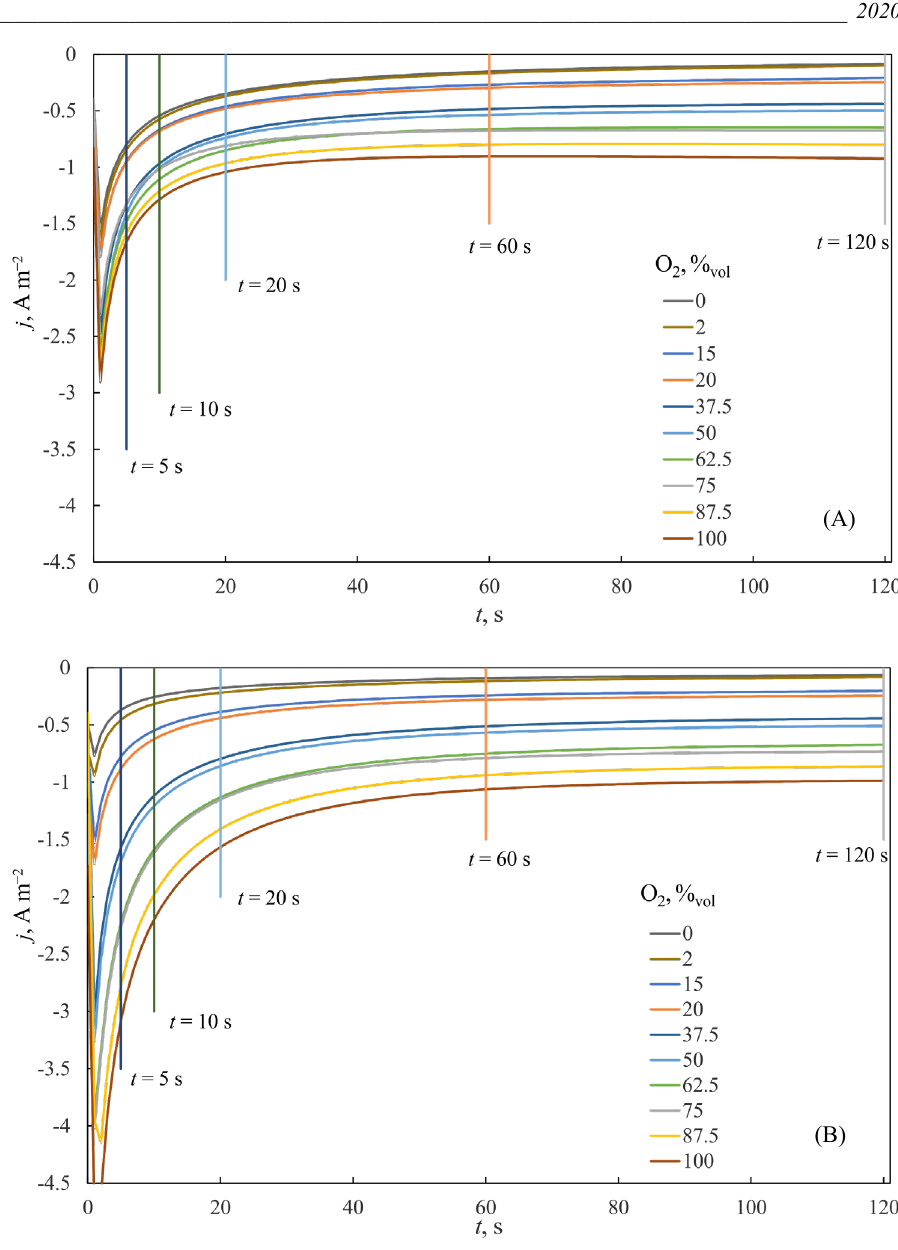
Fig. 5. The dependence of the current density, j , on the time, t , after the potential step of platinum electrode from 0.5 V to −0.5 V vs Ag|AgCl|0.1 M KCl for the 0.1 M KCl solution saturated with mixture of nitrogen and oxygen ( p tot = 101 kPa) at different partial pressures of oxygen. The pumping speed of the solution was 2 cm 3 min −1 . (A) Before and (B) after cyclic voltammetry